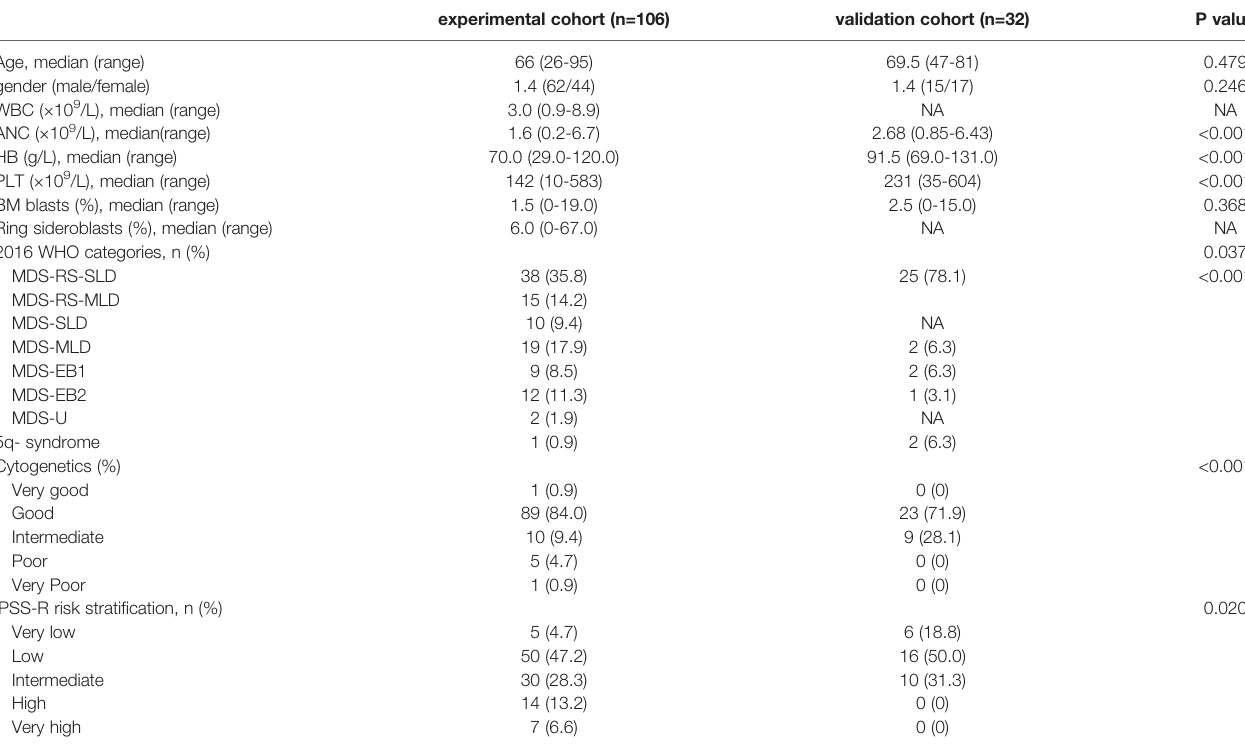
TABLE 2 | Comparison of basic characteristics of patients in the experimental cohort and the veri fi cation cohort. experimental cohort